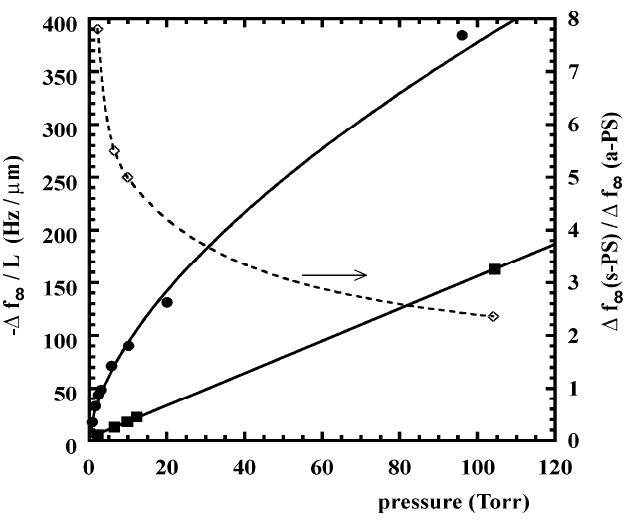
Figure 9. Comparison of the equilibrium response of a QCM sensor coated with a-PS (filled squares) and s-PS (filled circles) as a function of pressure of chloroform vapour. Empty diamonds represent the ratio of sensor outputs (s-PS coated output/a-PS coated output) as a function of